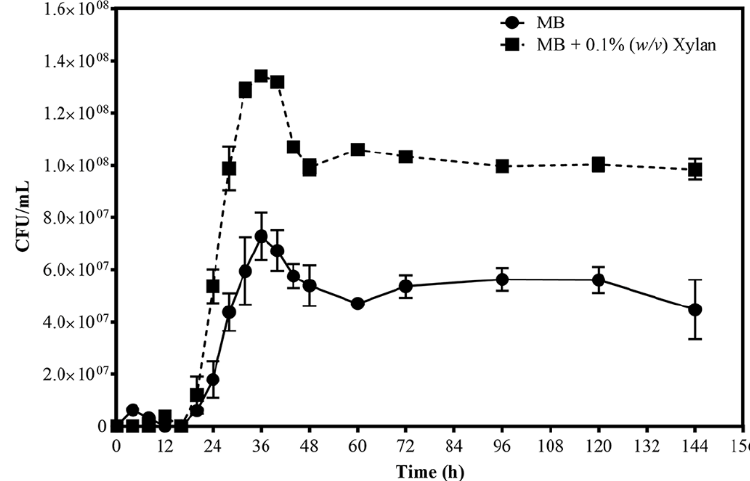
Figure 1. Growth profile of R. sacchariphilus strain RA grown on Marine Broth (MB) and MB supplemented with beechwood xylan (0.1% w/v ).